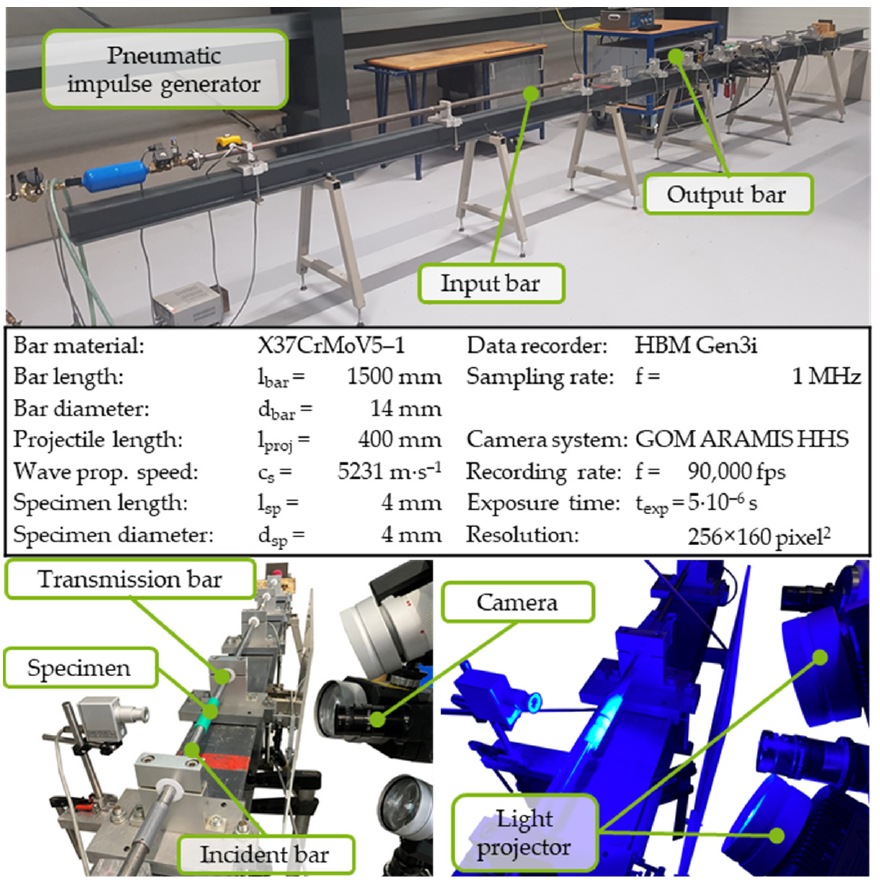
Figure 1. Experimental setup.